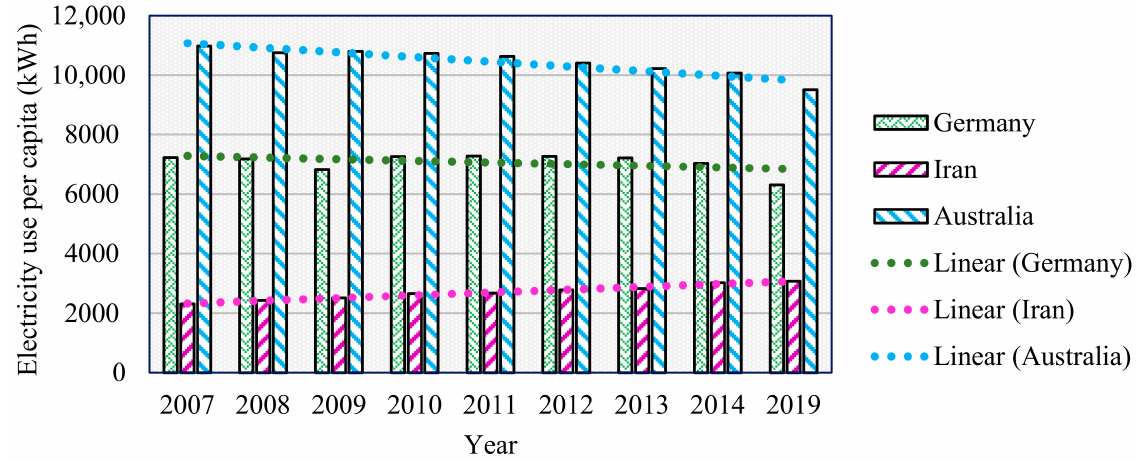
Figure 8. Electricity use per capita in Australia, Germany, and Iran (kWh).